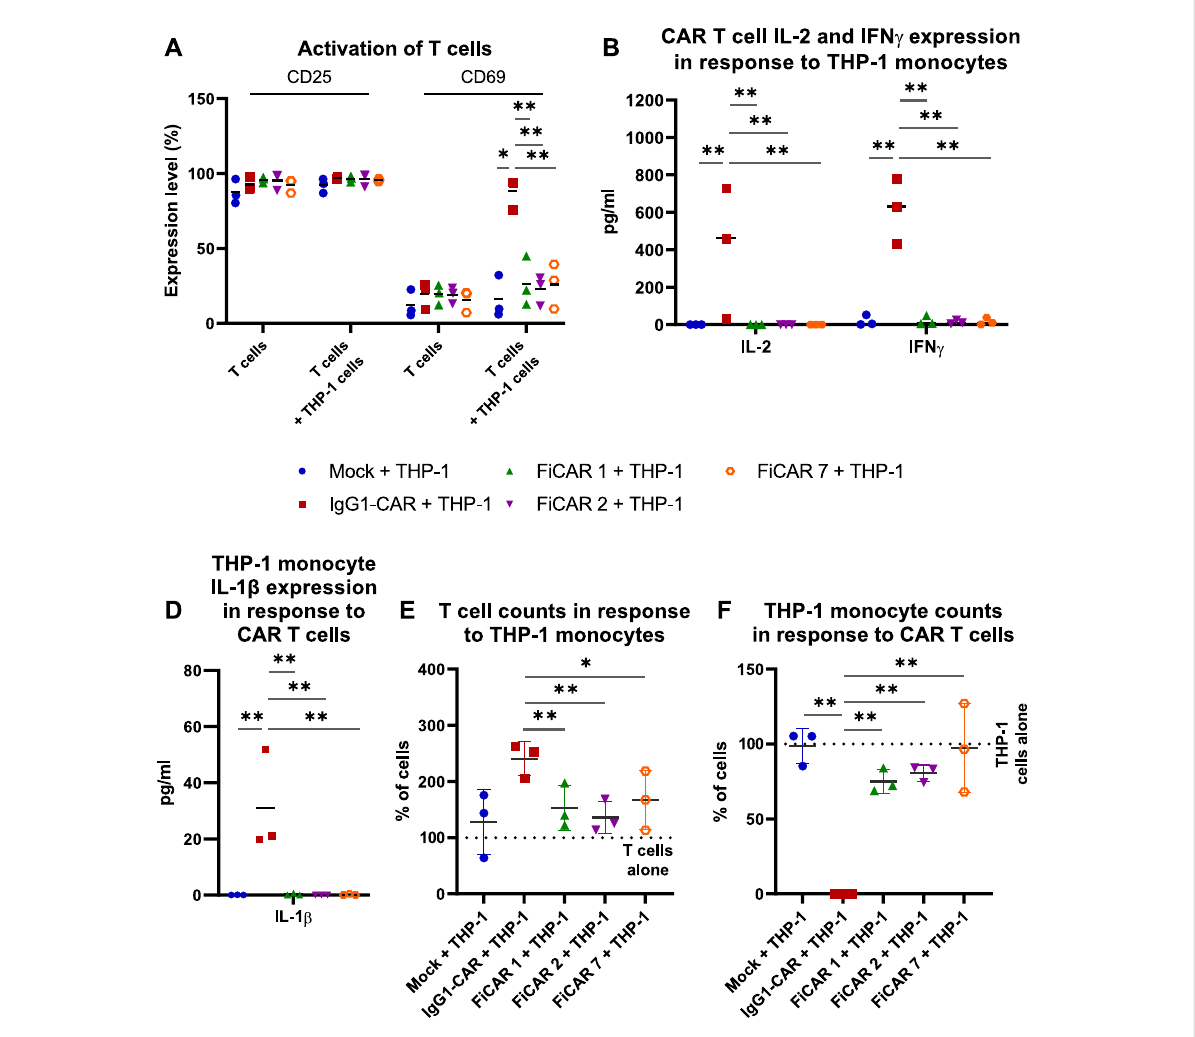
FIGURE 4 CAR T cell interactions with FcR-expressing THP-1 monocytes. CAR T cells were co-cultured with monocytes at a 1:1 (effector cell: off-target cell) ratio ( n = 3) for 18 h (A – C) or 48 h (D,E) . The activation of CAR T cells was measured by analyzing expression of cell surface activation markers [ (A) CD25, CD69; fl ow cytometry] and by measuring the CAR T cell and monocyte activation induced cytokines using a fl ow cytometry-based CBA array [ (B) CAR T cells: IFN γ and IL-2; (C) monocytes: IL-1 β ]. (D – E) : T cells (D) and THP-1 monocytes (E) were quanti fi ed by fl ow cytometry after co-culture for 48 h. 100% denotes the number of T cells (D) or THP-1 cells (E) cultured alone. The Mann-Whitney test (A,D,E) and one-way ANOVA with Bonferroni correction for multiple comparisons (B,C) were assessed for calculating the statistical signi fi cances (* p < 0.05; ** p <